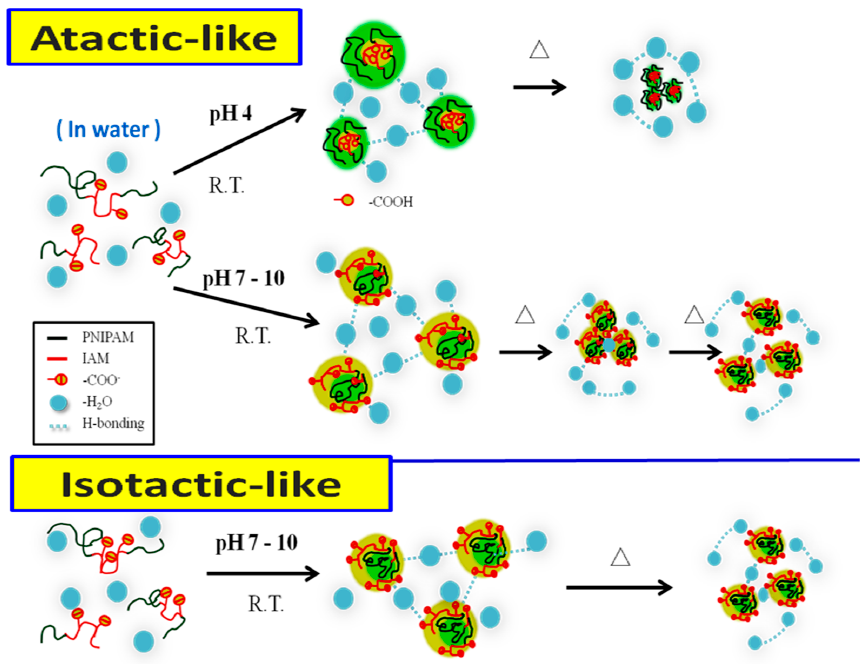
Figure 11. Proposed phase separation mechanism of 1 wt % aqueous solution of the atactic-like and the isotactic-like P(nipam-co-IAM) in the buffer solutions.